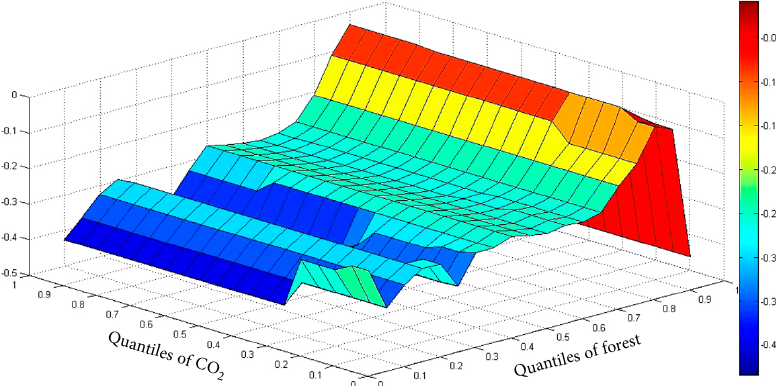
Figure 1. Quantile on quantile regression estimation for China